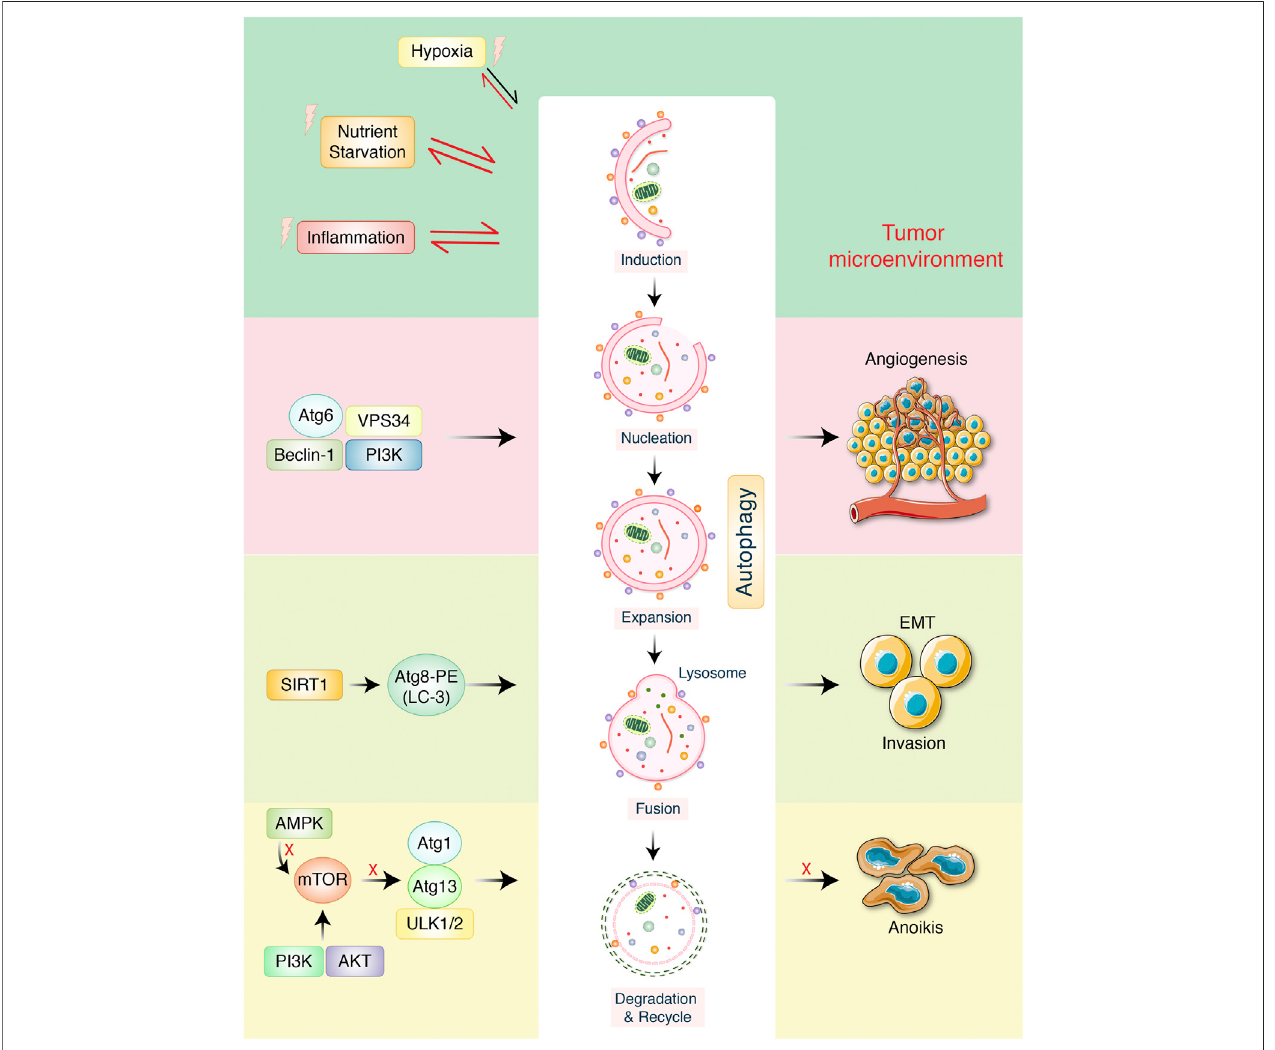
FIGURE 2 | Autophagy-mediated metastasis formation in gastric cancer. The autophagy-related proteins are involved in regulation in cancer. Starvation, hypoxia, and in fl ammation might be stimulated during autophagic process which create tumor microenvironment. VPS34, ATG6, beclin-1, and PI3K increase tumor angiogenesis.TranscriptionfactorSIRT1activatesautophagyimprovement via inducingATG8-LC-3-PEconjugation,whichlaterencouragesepithelial-to-mesenchymal transition (EMT), as well as tumor invasion. mTOR negatively regulates autophagy via inhibiting ATG13-ATG1-ULK1/2 protein complex. AMPK/PI3K regulates autophagy, which detached tumor cells to overcome